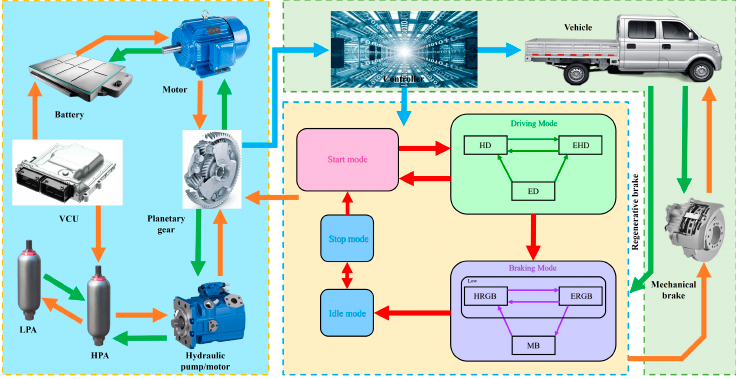
Figure 3. The flow chart of the conversion between different modes of MSEH-HEV.